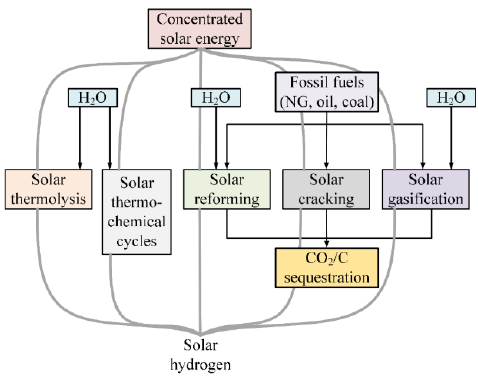
Figure 75. Five distinctive ways to produce solar hydrogen from concentrated solar power (CSP)